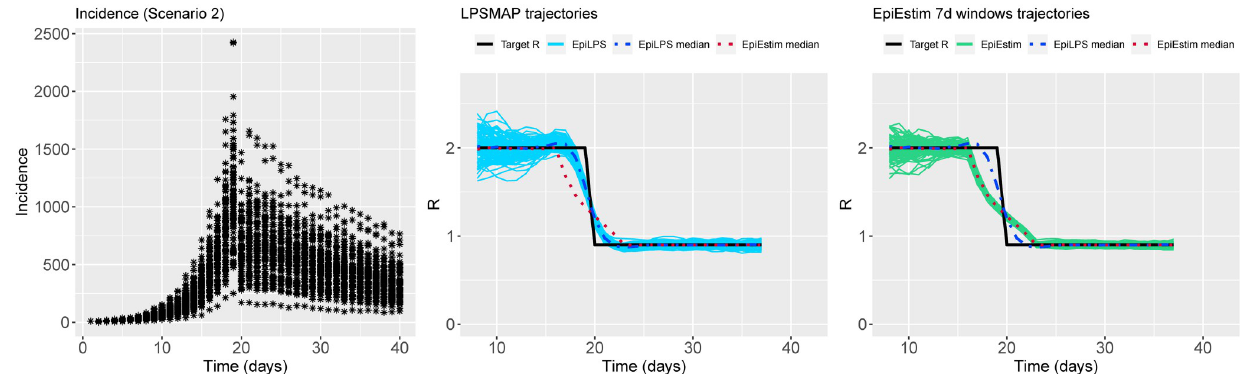
for each simulated dataset with LPSMAP. (Right) Estimated t reported at the window midpoint. The pointwise median estimate of R t